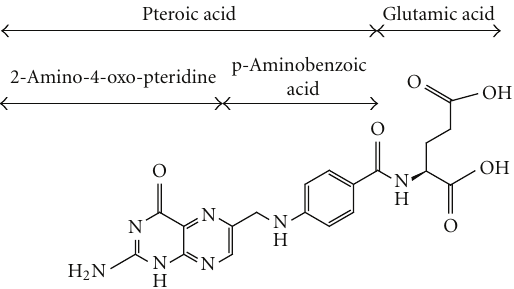
Figure 1: Structure of folic acid [1]. The three parts of the parent structure include 2-amino-4-oxo-pteridine, p-aminobenzoic acid, and glutamic acid. Substitutions (one-carbon groups) occur at the N5 and/or N10